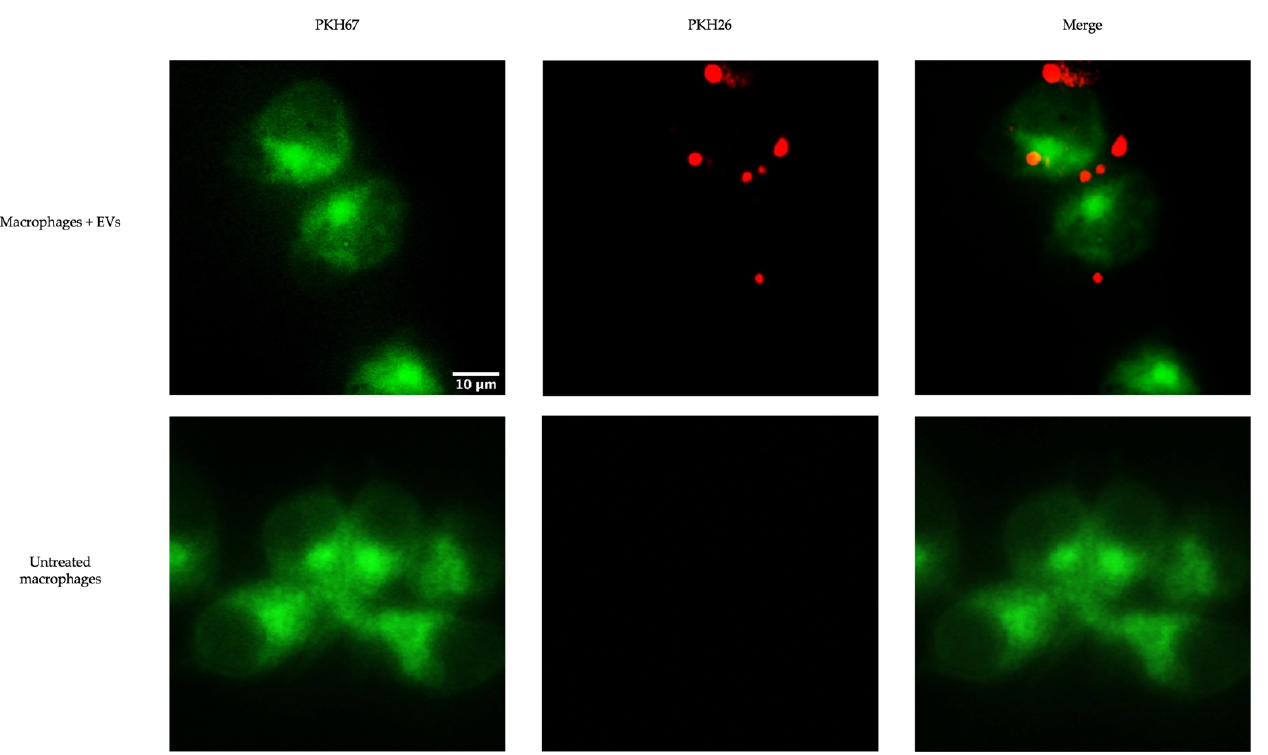
Figure 5. Uptake of EVs by chicken macrophage. PKH67-labelled ( green ) chicken macrophages were treated with 10 µg of the PKH26-labelled ( red ) EVs and incubated at 40 °C and 50% CO 2 for 2 h. The uptake of EVs by macrophages was detected by fluorescence microscopy.